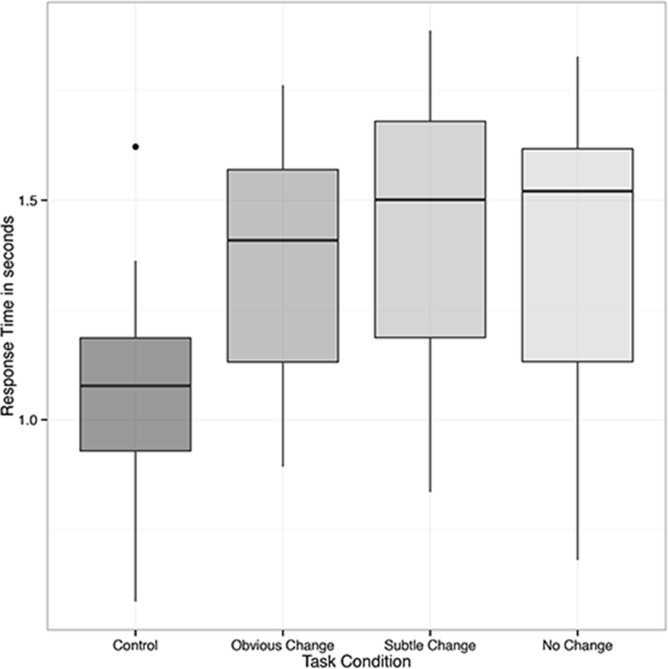
fNIRS task response time.Inter-quartile ranges of fNIRS task response times across each trial type. Similar to the task accuracy outcome, the predicted pattern of faster median trial response times for control trials was identified, followed by “obvious change”, “subtle change”, and “no change” trials in that order.